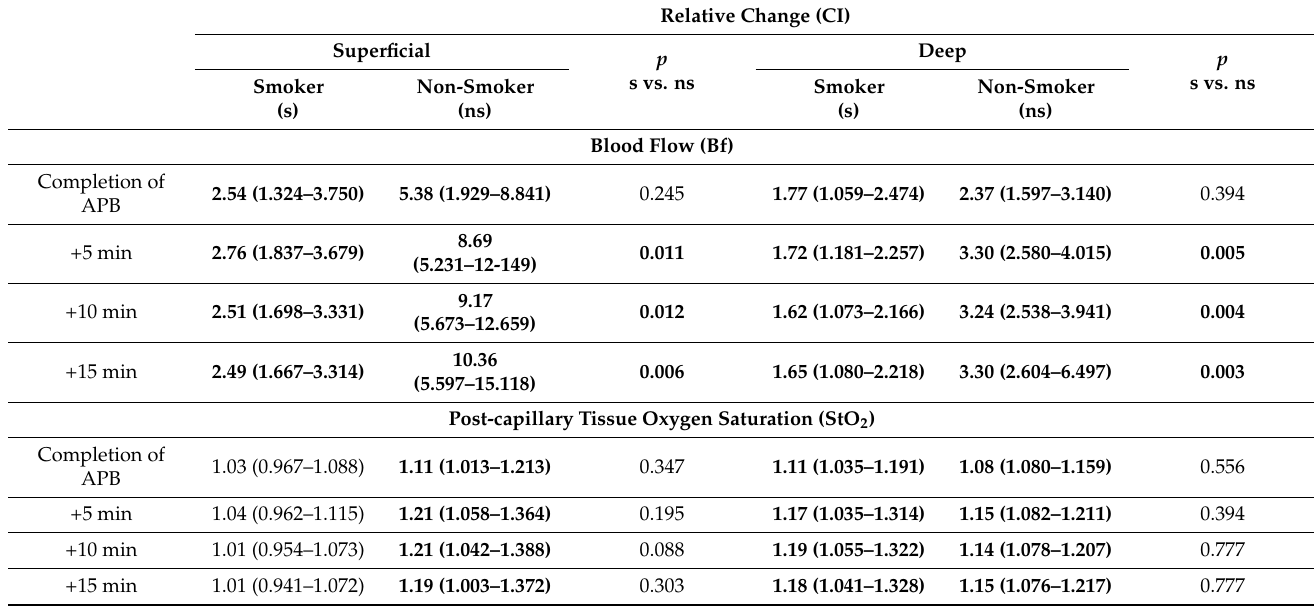
Table 2. Microcirculatory subgroup analysis smoker vs. nonsmoker.